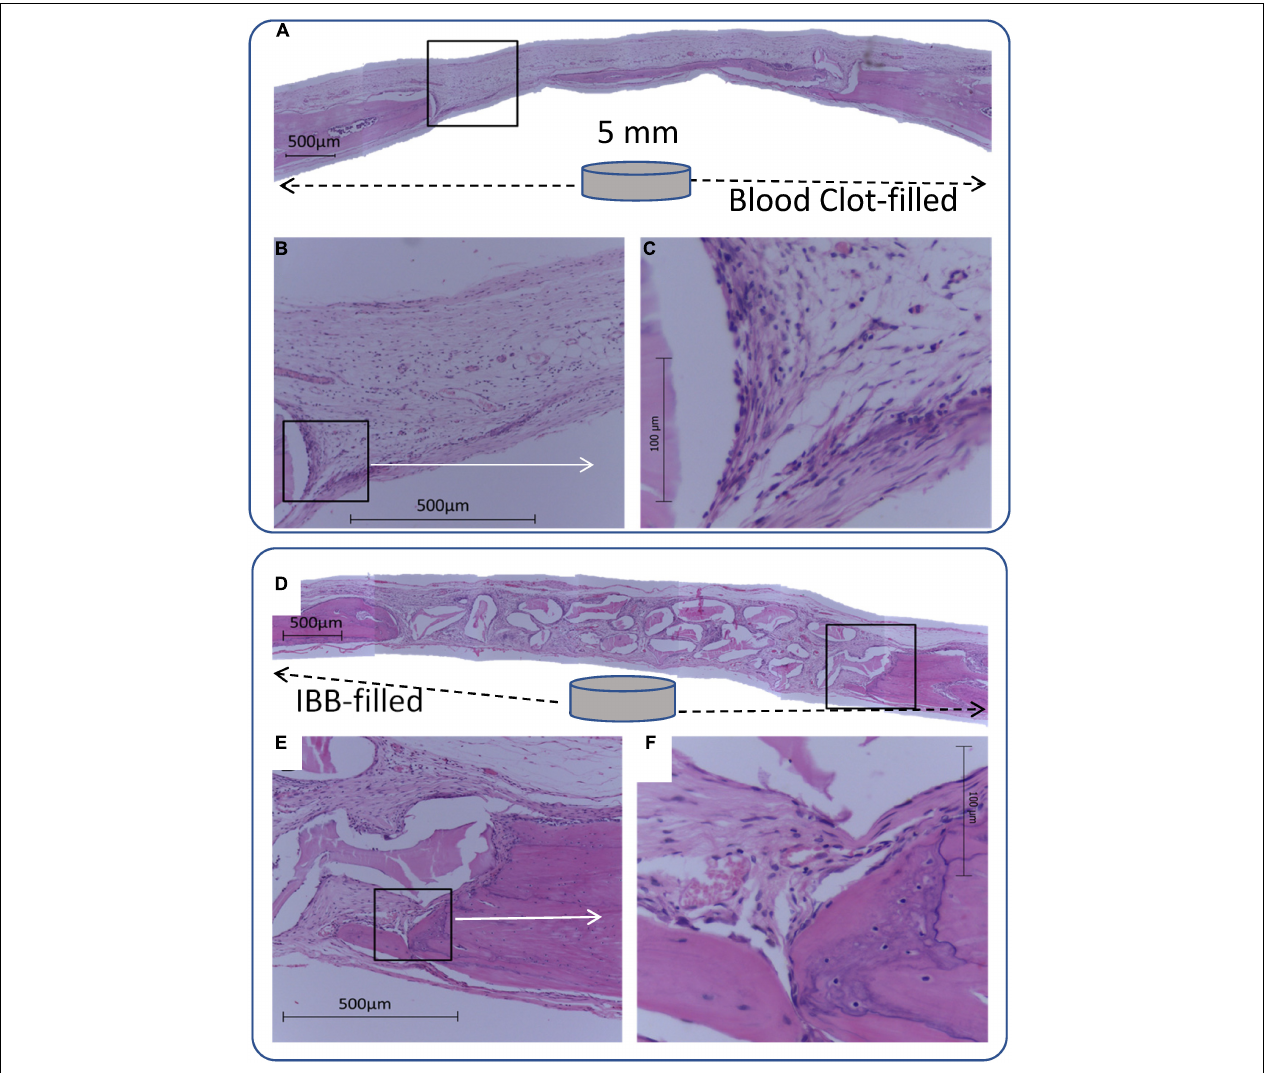
FIGURE 3 | Panoramic view of a 5-mm-diameter defect produced in a rat. Cavity defects were filled with blood clot (A–C) or inorganic bovine bone (D–F) , associated with 7 sessions of laser irradiation can be compared. Images were magnified (C and F) to highlight the recovery process, suggesting an improvement when the filling of the cavity is through IBB, as indicated by intense osteoblastic and fibroblastic activity at the margins with deposition of bone matrix and collagen